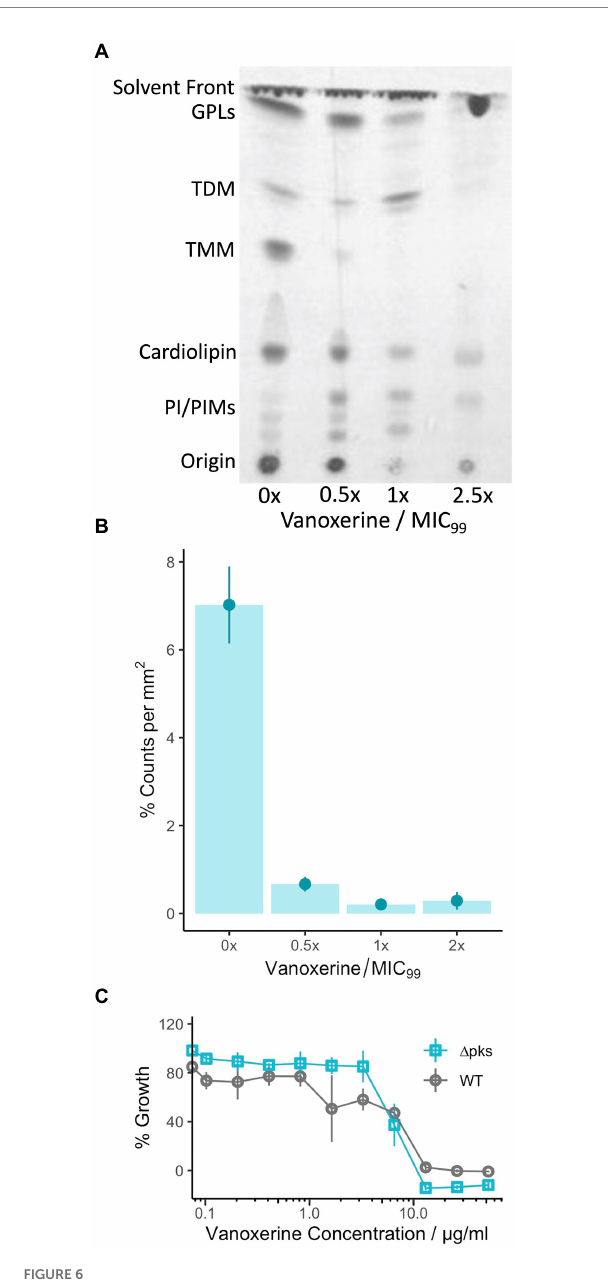
FIGURE 6 Vanoxerine treatment impacts the mycolic acids in M. smegmatis , but this inhibition is unlikely to be the main mechanism of inhibition. (A) Thin-layer chromatography (TLC) of M. smegmatis lipid extractions, showing loss of TMM. M. smegmatis wild-type was treated with vanoxerine for 24-h, followed by a total lipid extraction. TLC was performed (CH 3 Cl/MeOH/H 2 O, 80:20:2, v/v/v), followed by exposure to an X-ray film to image. MIC = 26 μ g/ml, GPL, glycopeptidolipids; TDM, trehalose dimycolates; TMM, trehalose monomycolates; PI, phosphatidylinositol; PIMs, phosphatidylmannosides. Representative image from N = 4. (B) Densitometric analysis of TMM loss following vanoxerine treatment. The same silica plates were exposed to a storage phosphor screen and then scanned to quantify the radioactivity of each spot. The counts for the TMM spot were compared to the total counts in each lane, to generate a %counts per mm 2 . N = 4. (C) %Growth comparing C. glutamicum WT versus ∆ pks13 mutant in the presence of vanoxerine. C. glutamicum was incubated with vanoxerine for 24 h, before OD 600 was measured. The % survival was calculated compared to DMSO-only and rifampicin controls. N =